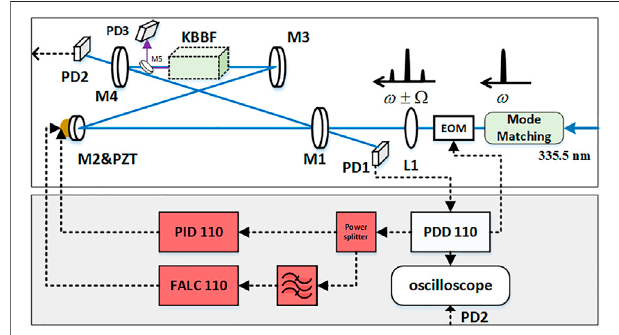
FIGURE 3 | Experimental setup of the resonant cavity based on the KBBF crystal. M1-M5: cavity mirror, PD: Photodetector, PZT: Piezo electric transducer, EOM: electronic-optical modulator.